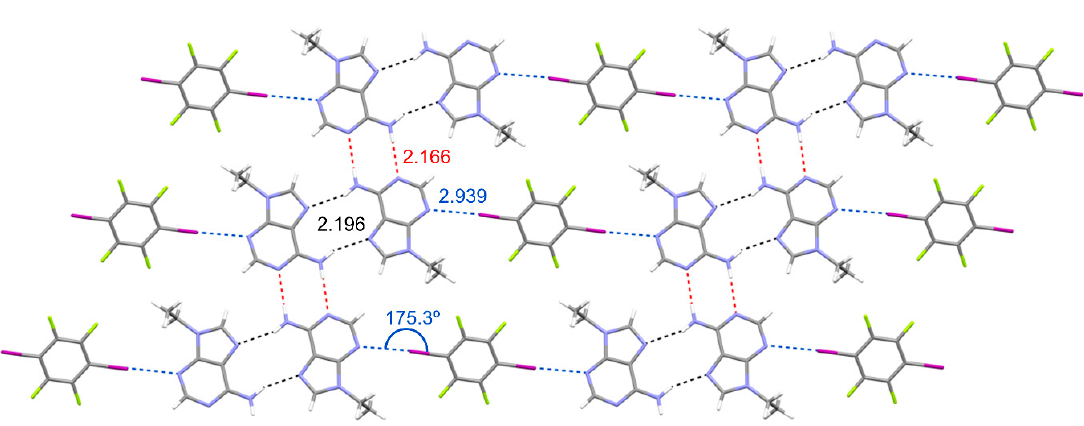
Figure 3. N 9 -ethyladenine – TFDIB cocrystal planes formed by zig-zag N 9 -ethyladenine tapes linked by TFDIB. Distances in Å.